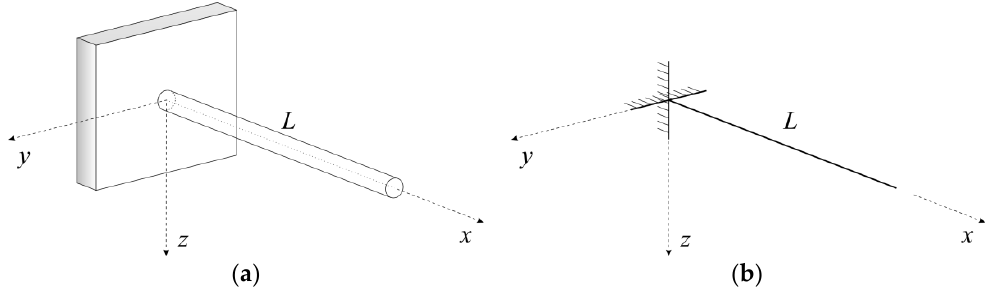
Figure 2. ( a ) A three-dimensional body; ( b ) A numerical model of the